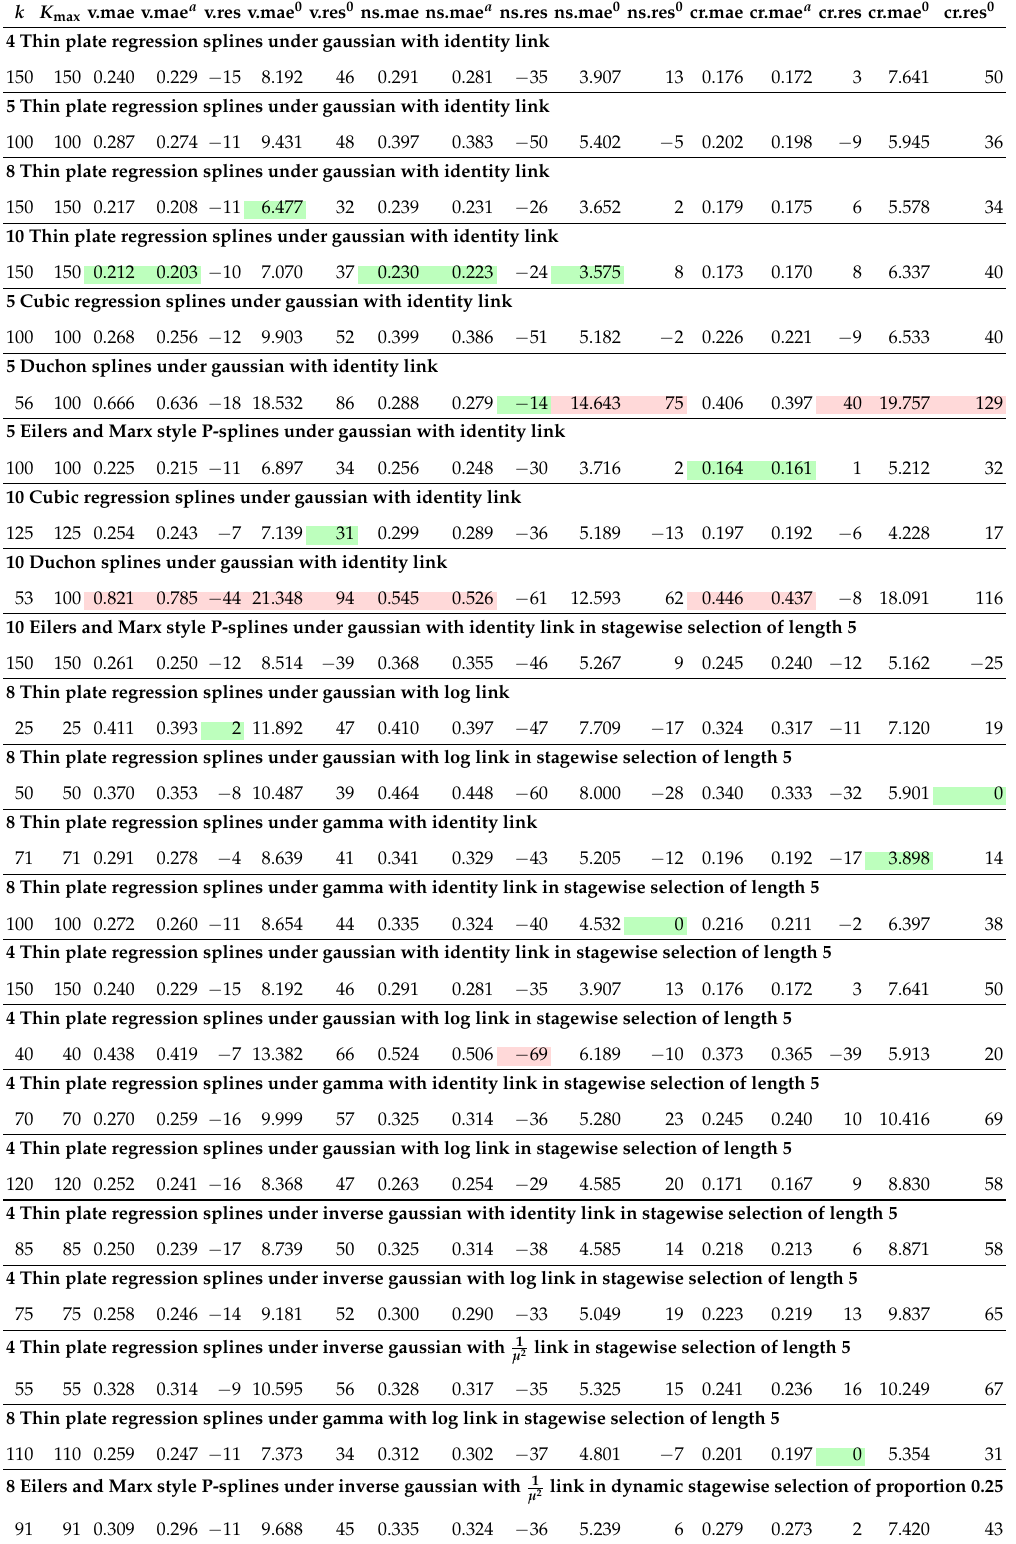
Table A23. Maximum allowed numbers of smooth functions and out-of-sample validation figures of all derived GAMs of BEL under between 25–443 and 150–443 after the final iteration. Highlighted in green and red respectively the best and worst validation